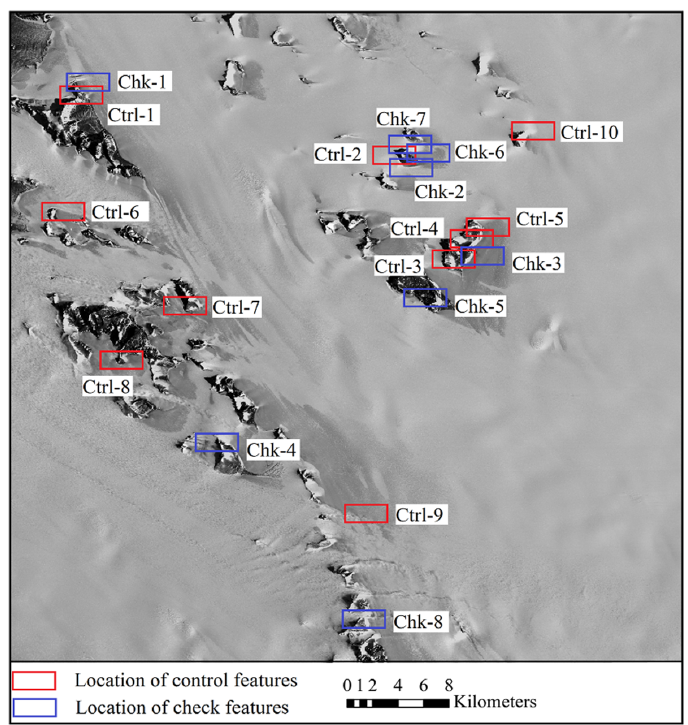
Figure 6. Distribution of the control features and the check features for the ZY ‐ 3 images.